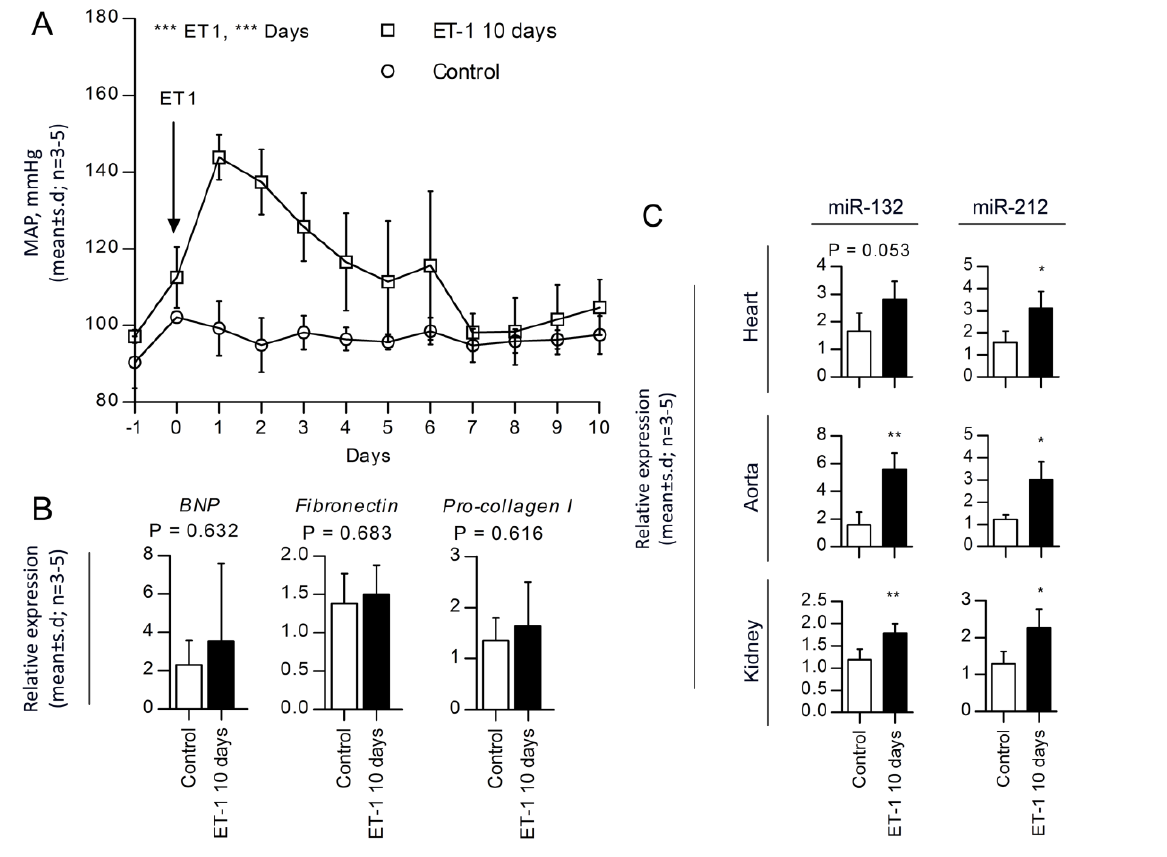
Figure 4. Endothelin 1-induced hypertensive rats. ( A ) Mean daily averages of mean arterial blood pressure from five rats treated with chronic infusion of 5 pmol/kg/min ET-1 for 10 days ( □ ), compared to three control rats ( Ο ). Statistical significance was tested by two-way ANOVA. *** p < 0.001; ( B ) qRT-PCR for the early hypertrophy marker, BNP and the fibrosis markers, Fibronectin and Procollagen-I . Statistical significance was tested by un-paired t -test. Data is shown as the mean ± SD, n = 3–5. Reference genes used for normalization: GAPDH and Rpl13a (M: 0.153, CV: 0.053); ( C ) qRT-PCR identification of miRNAs in the left ventricle of hearts, aortas and kidneys from ET-1 affected rat hearts. Statistical significance was tested by un-paired t -test. * p < 0.05. Values are shown as relative expression with the mean ± SD, n = 3–5. miRNA expression was individually normalized to two reference genes stably expressed among the samples. Reference genes used for normalization: heart; miR-17 and miR-191 (M: 0.309, CV: 0.107); aorta, miR-103 and miR-191 (M: 0.667, CV: 0.232); kidney, miR-17 and miR-191 (M: 0.180, CV: